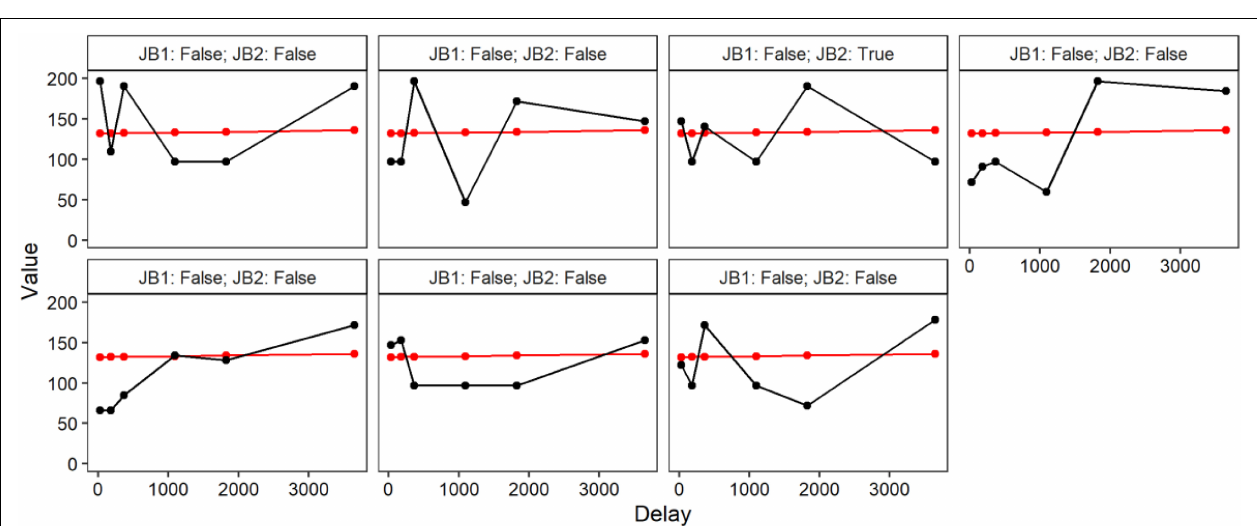
FIGURE 2 | Composition of Non-systematic discounter